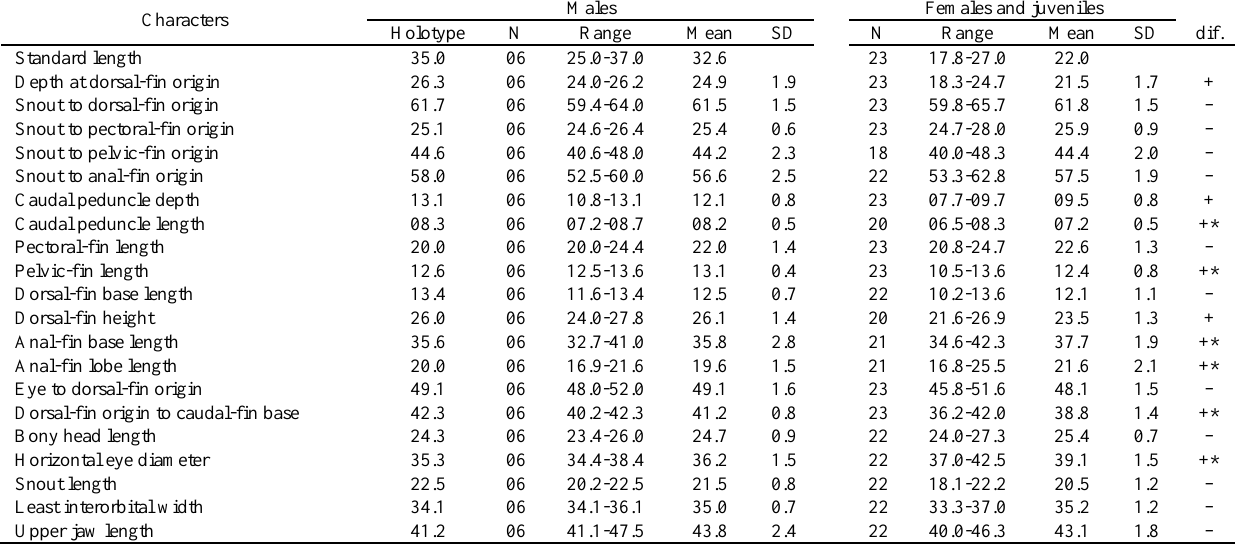
Table 8. Morphometrics of Mimagoniates pulcher . Standard length is expressed in mm; measurements through bony head length are percentages of standard length; the last four entries are percentages head length. A plus sign under the abbreviation dif indicates there is a significant statistical difference between the males and females in the particular character indicated. Those receiving a plus sign and an asterisk are probably not significant. Specimens are from “Porto Velho-São Luiz de Cáceres, Mato Grosso, Brazil, MNRJ 4233. SD = Standard